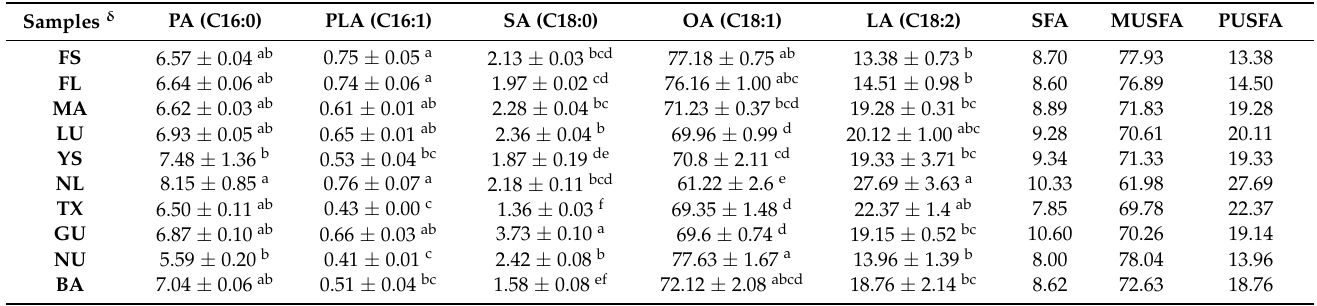
Table 2. Some physicochemical and bioactive properties of almond samples